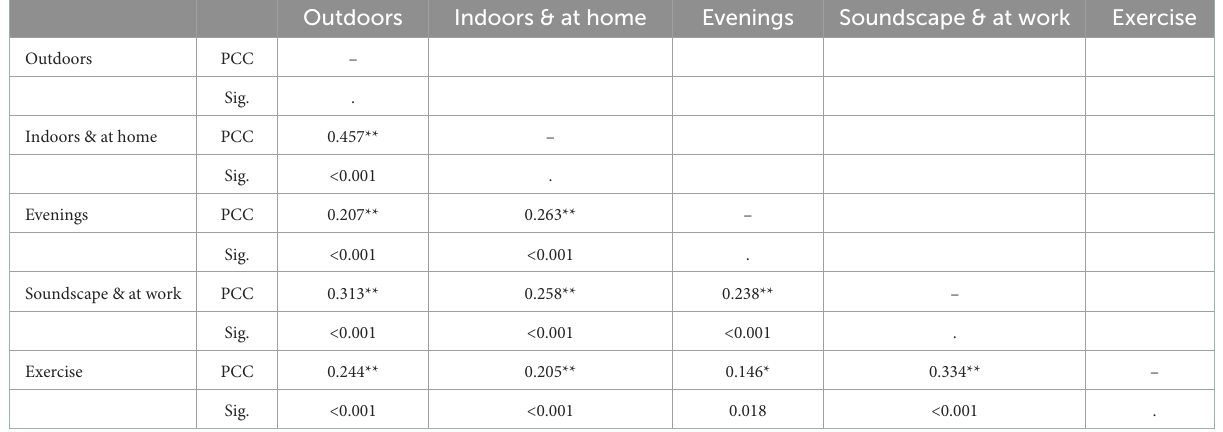
TABLE 2 Pearson’s product-moment correlations amongst the five factors produced by the EFA ( N = 264). Outdoors Indoors & at home Evenings Soundscape & at work